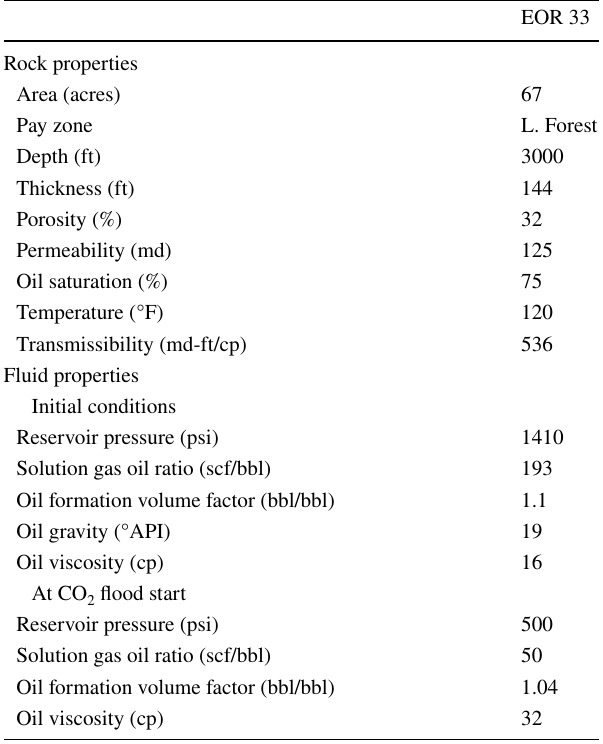
Table 2 Reservoir data EOR33 ( source Mohammed-Singh and Sin- ghal